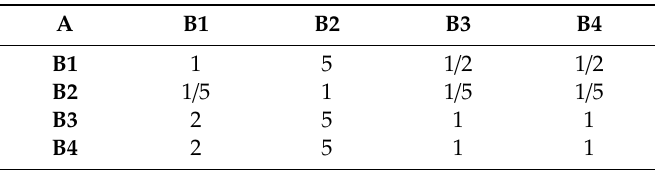
Table 4. Judgment matrix of the criteria layer (layer